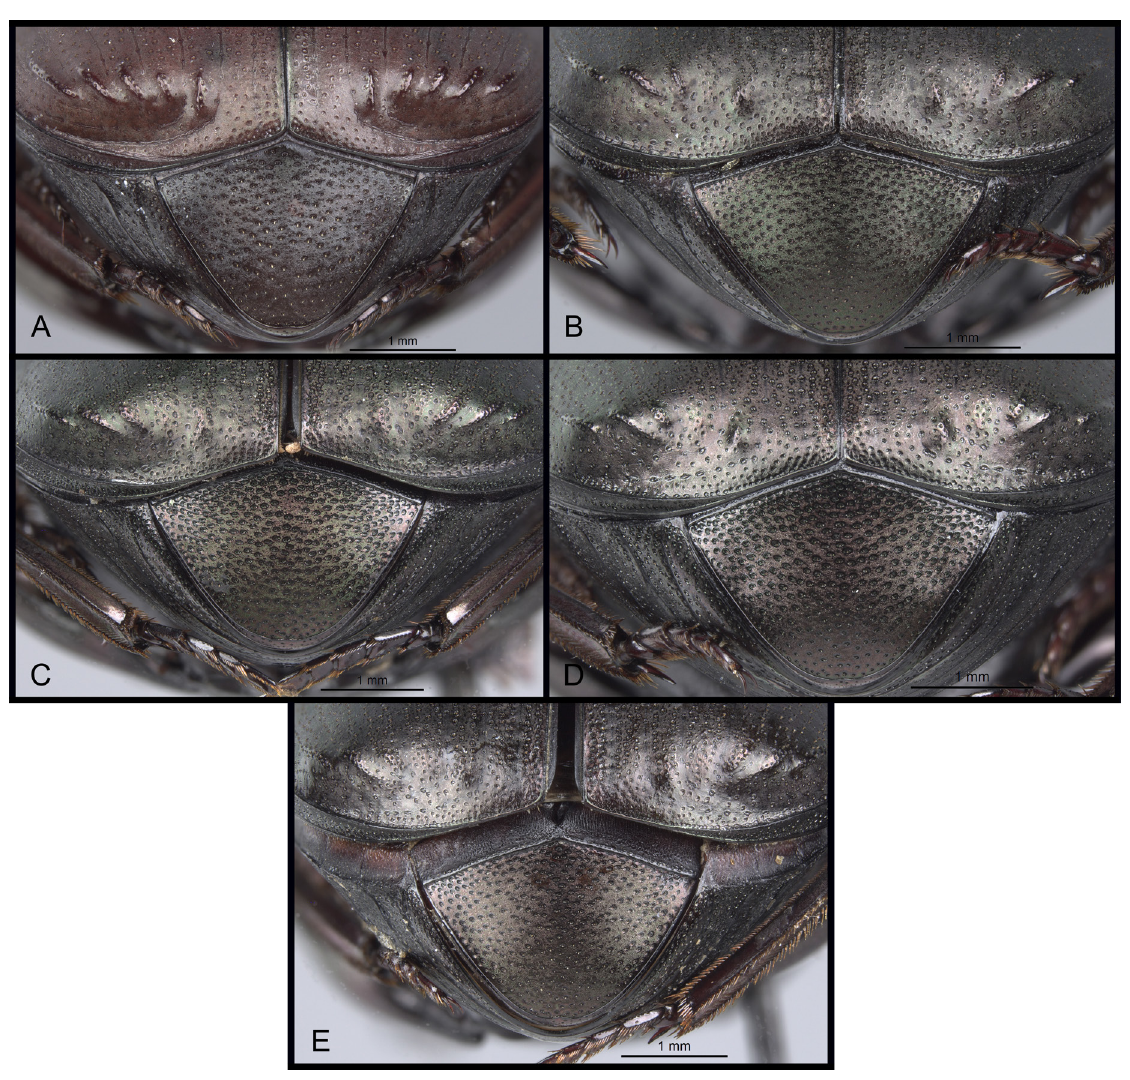
Fig. 5. Caudal view of mmbers of the gilli species group. A . Holotype of Deltochilum gilli González- Alvarado & Vaz-de-Mello, 2021, CNCI 379888. B . Holotype of D. jocelynae sp. nov., CNCI 379889. C . Holotype of D . nonstriatum sp. nov., CMNEN WSD00041746. D . Holotype of D . quasistriatum sp. nov., CMNEN WSD00041744. E . Holotype of D . tenuistriatum sp. nov., CMNEN